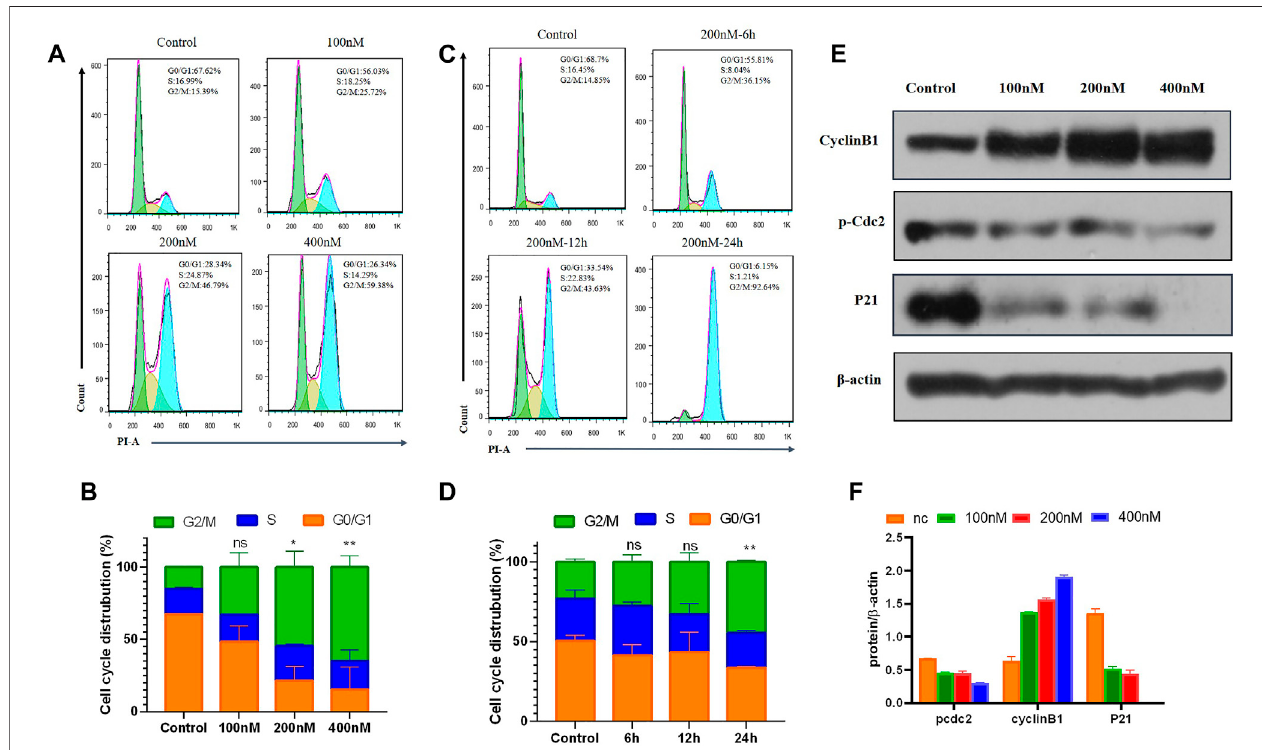
FIGURE6| Compound7minducedcellcyclearrestinG2/MarrestonMCF-7cells. (A) Cellsweretreatedwithindicatedconcentrationsof7mfor24 h,andpro fi les wereobtainedby fl owcytometry. (B) Thepercentageofcellcyclefrom (A) isillustratedinplots (C). Cellsweretreatedwith200 nM7mfor0,6,12,24 h,respectively,and analyzed by fl ow cytometry. (D) The percentage of cell cycle from (C) is illustrated in plots. (E) MCF-7 cells were treated with 7m, then the cells were harvested, and the protein expressions ofCyclinB1, p -Cdc2,and P21weredetectedbyWesternblotting assay. (F) Quantitative analysisofthe expression ofCyclin B1, p -Cdc2,and P21 from experiments as in (E) . Data are presented as mean ± SD of at least three independent